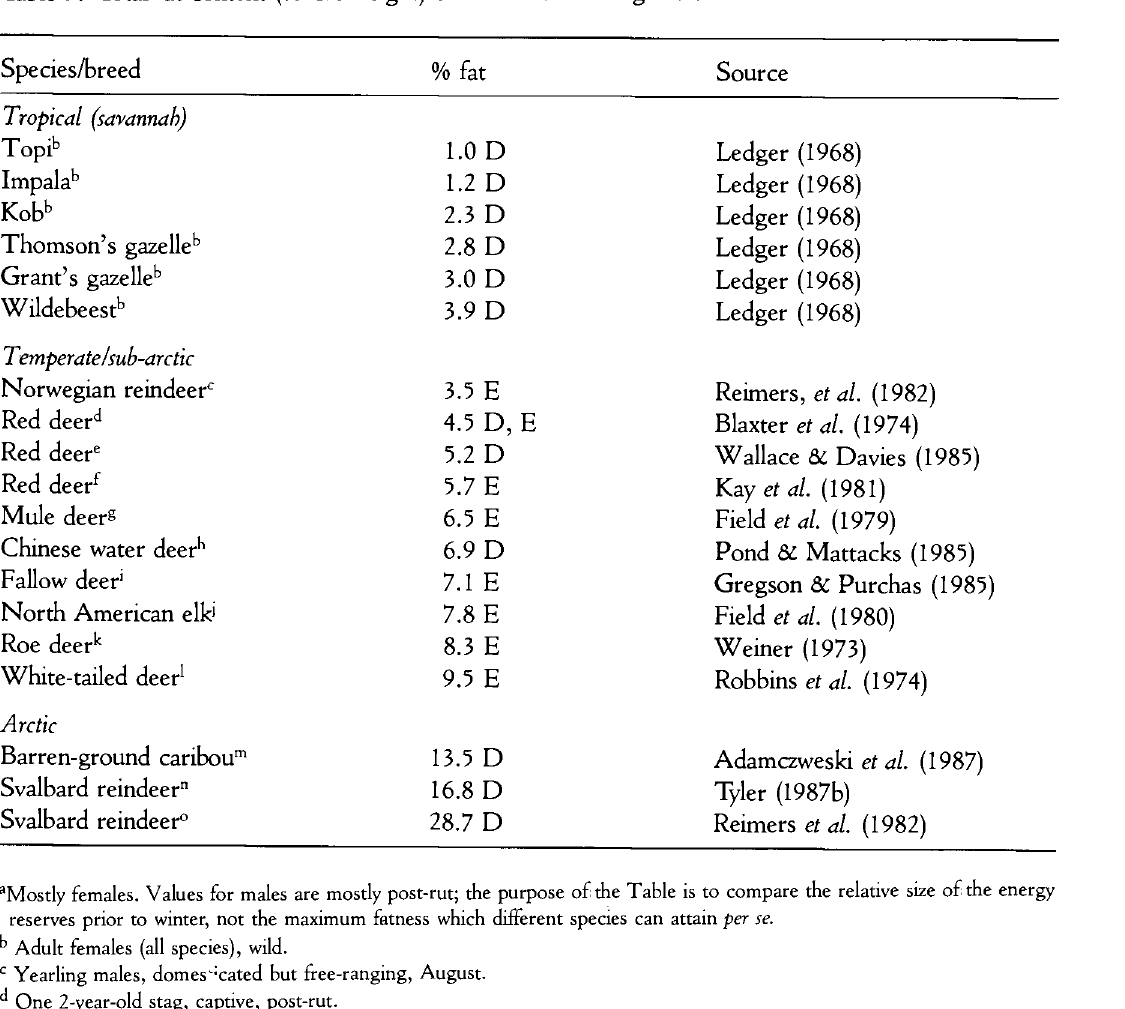
Table 3. Total fat content (% live weight) of different wild ungulates 3